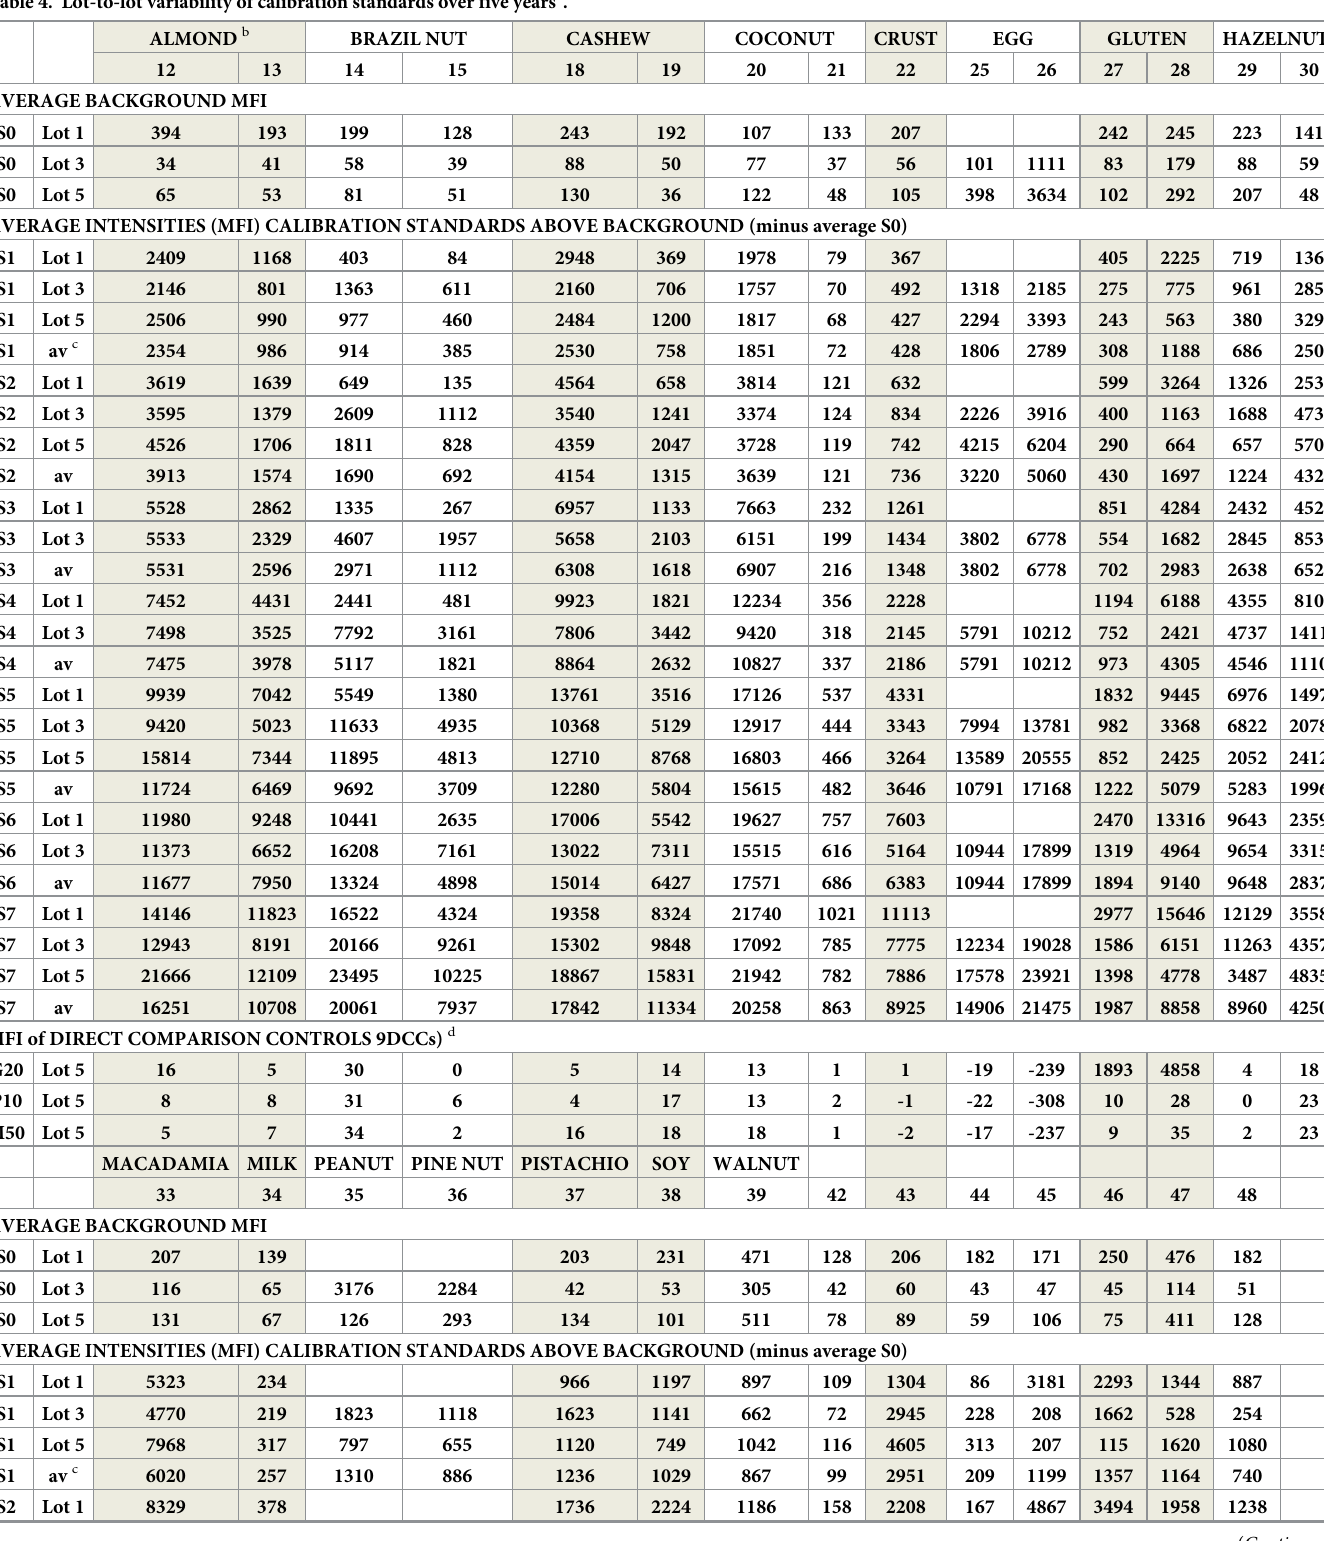
Table 4. Lot-to-lot variability of calibration standards over five years a